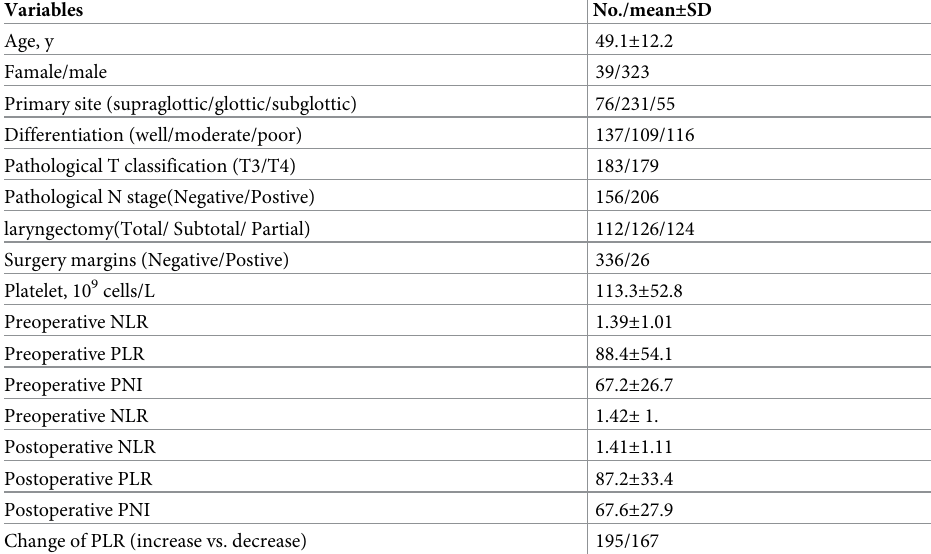
Table 1. Patients’ characteristics of the study.